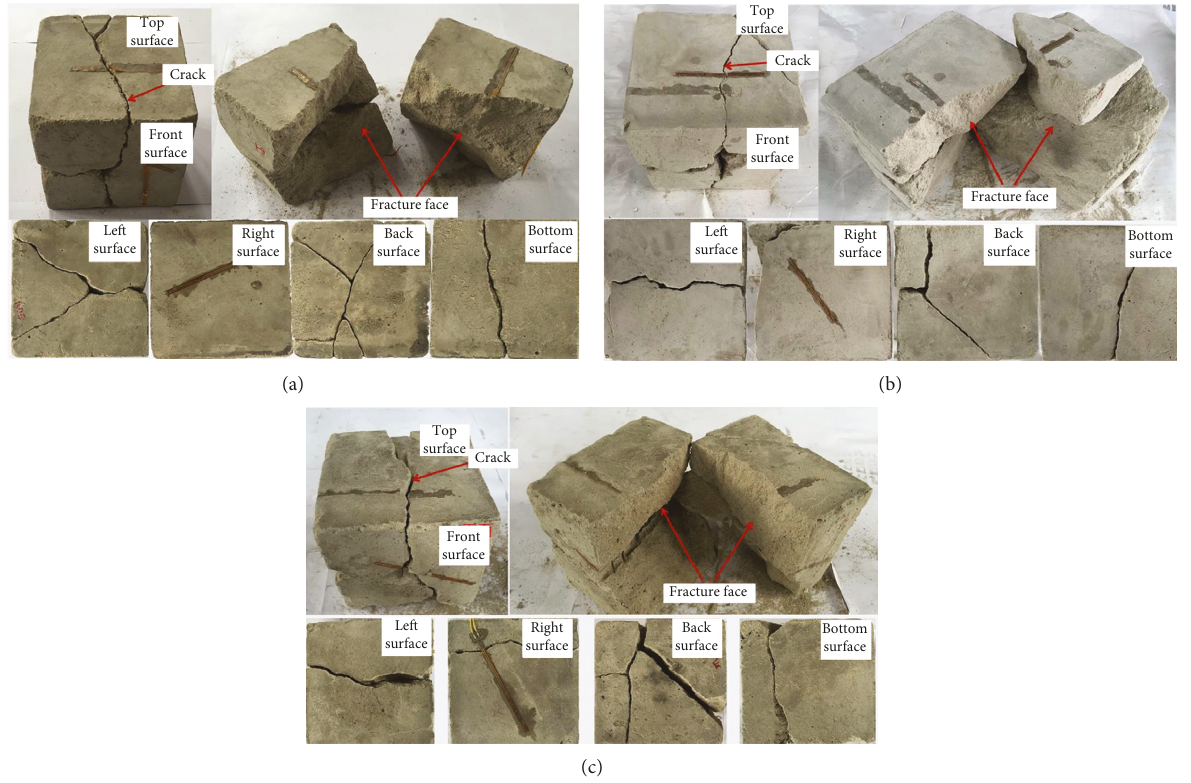
Figure 6: The macroscopic crack morphology on the experimental blocks’ surface under the designed condition of gas pressure of 10MPa: Table 3: Statistical table of characteristic parameters of damaged experimental blocks.